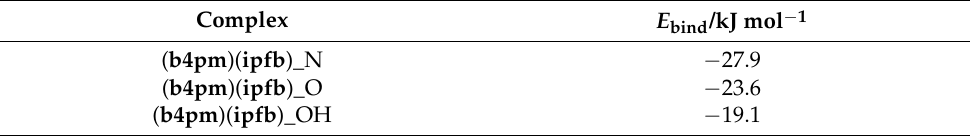
Table 2. Binding energies of the ipfb molecule to the different acceptor atoms of b4pm